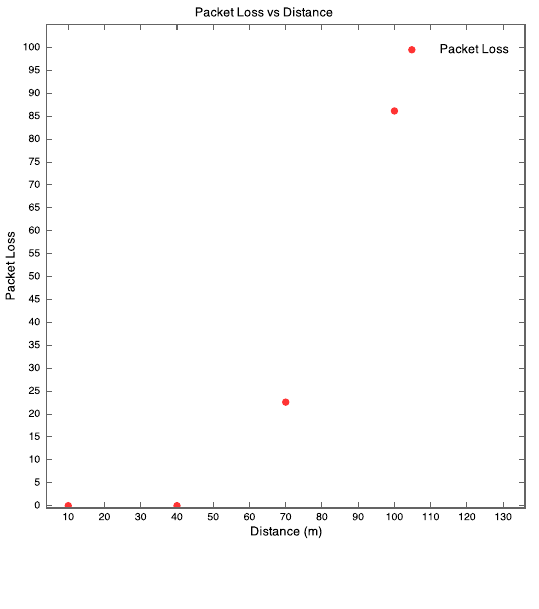
Figure 10. RSSI vs. Time for Experiment